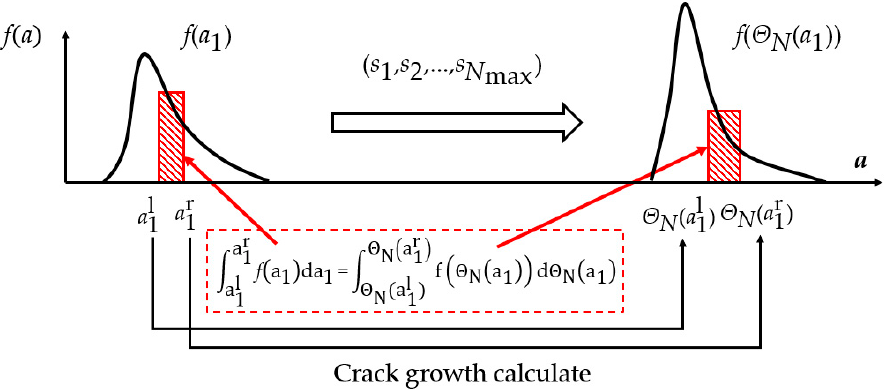
Figure 3. Sketch map of crack length distribution evolution.